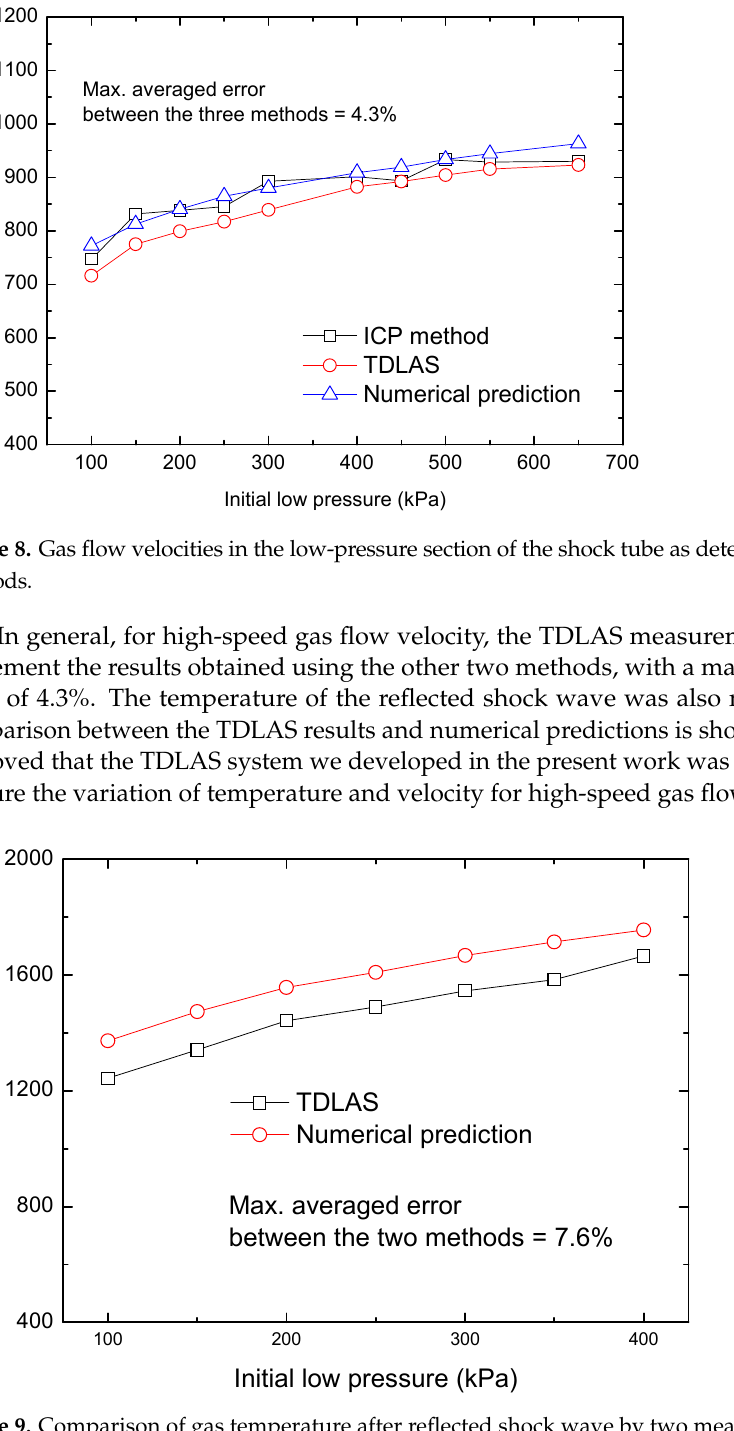
Figure 9. Comparison of gas temperature after reflected shock wave by two measurement methods.